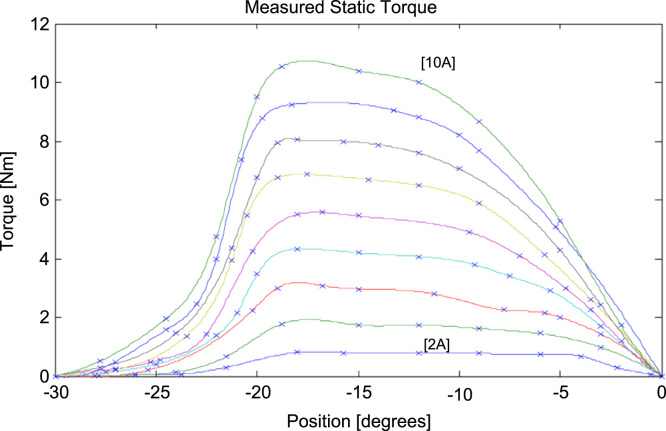
Measured data of static torque [12].